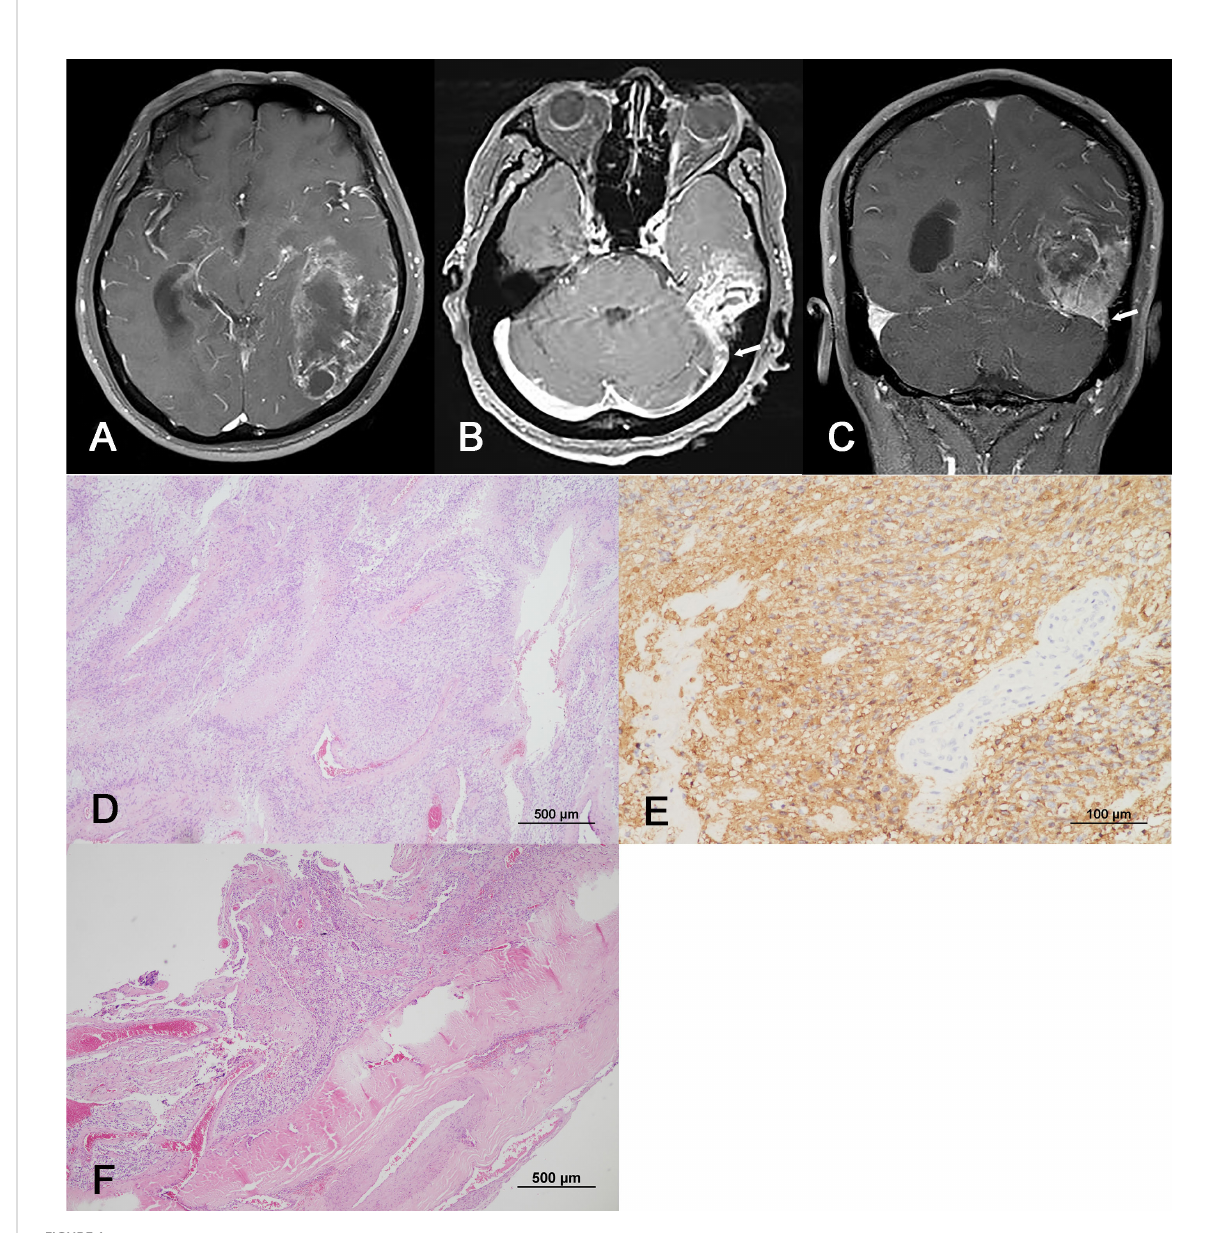
FIGURE 1 Radiological and pathological images of the initial mass. (A – C) Preoperative Gd-enhanced T1-weighted MRI showing a heterogeneously enhanced mass in the left temporal region with leptomeningeal involvement. Note the lesion invading the transverse and sigmoid sinuses (arrow head). (D, E) Representative microphotos of the primary surgical sample with palisading tumor cell necrosis and GFAP immunopositivity, consistent with a diagnosis of glioblastoma. (F) The removed dural tissue is involved by glioblastoma ( D, F : hematoxylin and eosin